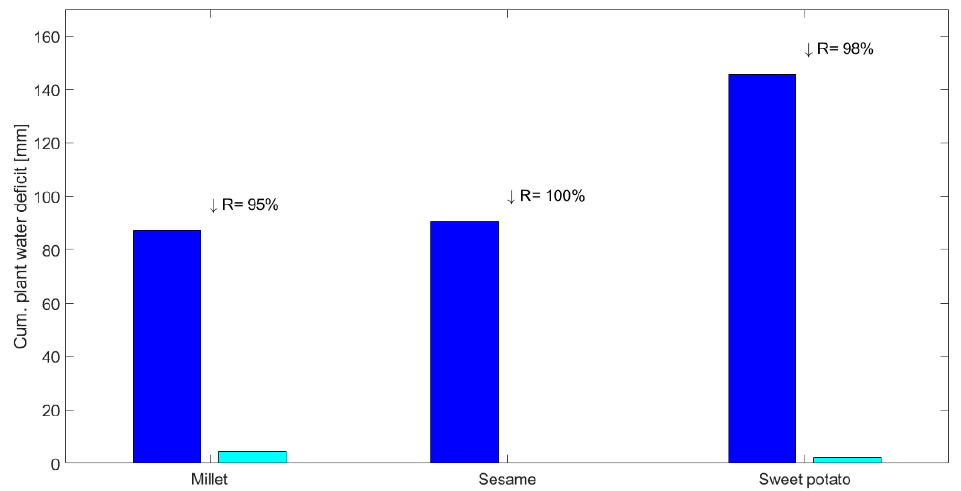
Figure 9. Cumulative plant water deficit induced by the use of the traditional sowing method (blue bars) or adopting half-moons with a pond depth of 10 cm (cyan bars) for three traditional Sahelian crops. R values indicate the deficit reduction when HM 10 are used.